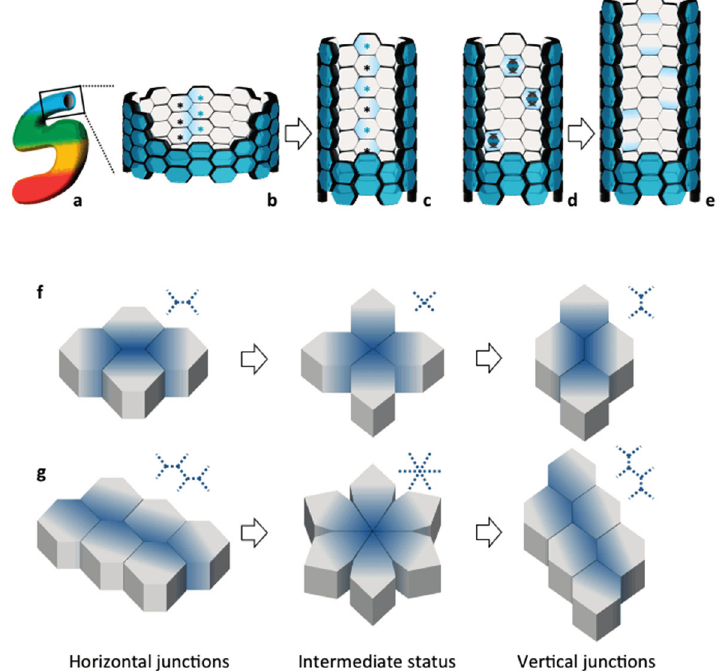
Figure 3. Narrowing and elongation of developing renal tubules and collecting ducts. During embryonic development, the S-shaped body tubular structure ( a ) elongates and establish its diameter in a proliferation-independent manner: because cells intercalate perpendicularly to the longitudinal axis, the tubule becomes narrower and longer without changing cell number ( b , c ); in post-natal phases, the longitudinal orientation of cell division allows to maintain the diameter and to increase length of the tubule ( d , e ). During cell intercalation, cells resolve from a horizontal status to a vertical one passing through an intermediate cross-shaped state ( f ) When re-shaping involves a larger number of cells, the intermediate status displays a rosette profile ( g